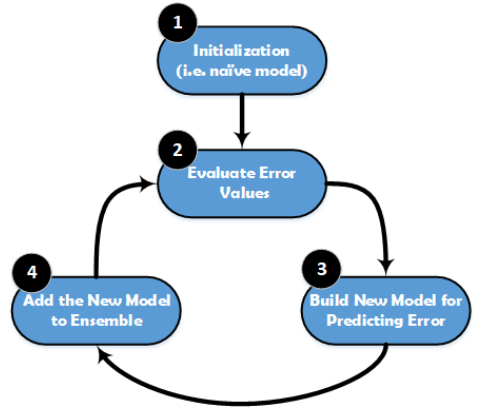
Figure 5. Structure of the XGBoost classifier.